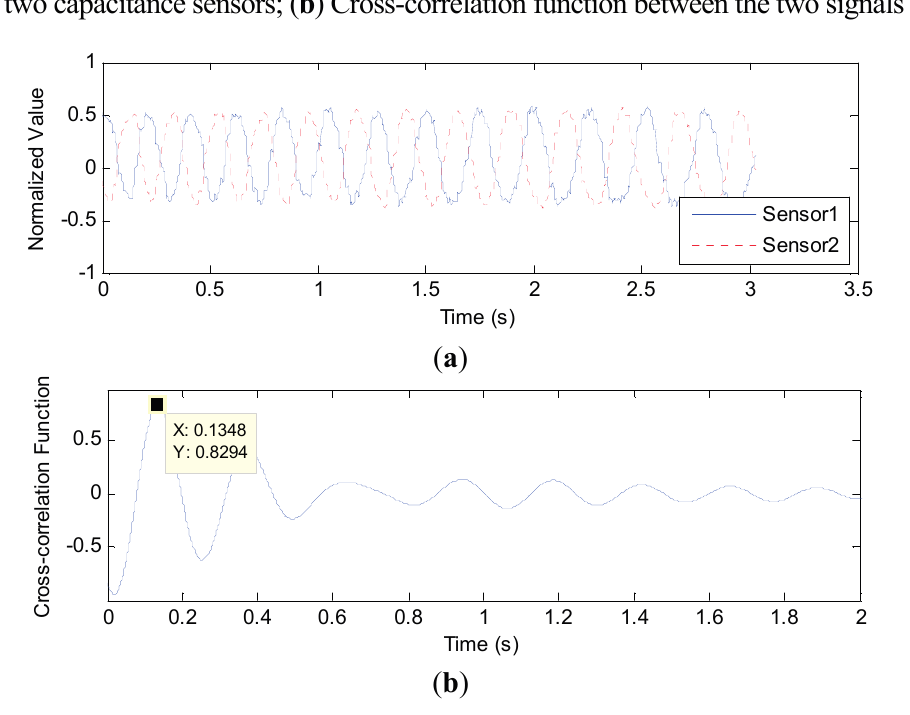
Figure 8. Signal waveforms and the resulting correlation function in 1.56 mm inner diameter pipe with 10.0 mL/min gas flowrate and 1.0 mL/min liquid flowrate: ( a ) Normalized signals